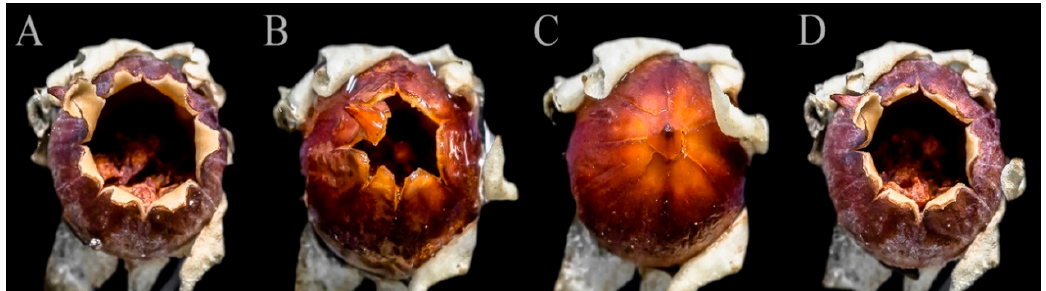
Figure 2. Hygroscopic movement of P. palinuri capsules: ( A ) dry capsule; ( B ) capsules wetted with sprinkling distilled water; ( C ) end of closing process, average duration 10 min; ( D ) reopening due to drying out, average duration 120 min.